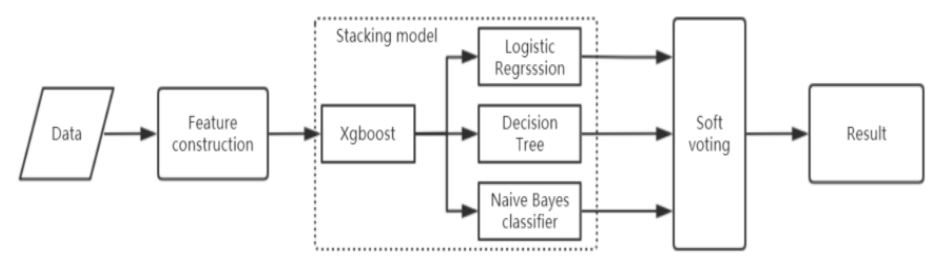
Figure 1. The proposed customer-churn prediction system.